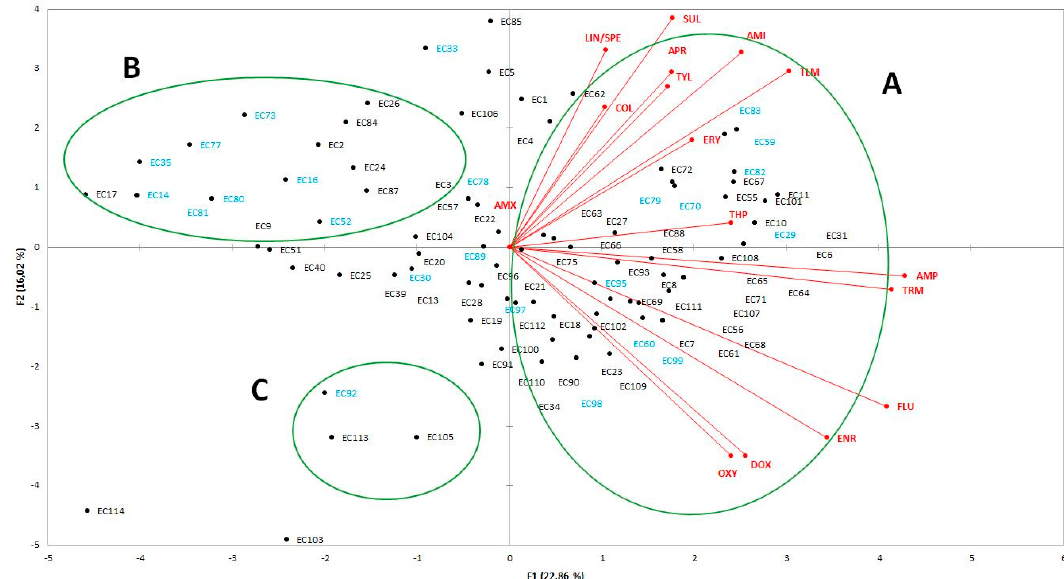
Figure 1. Biplot of principal component analysis (PCA) analysis showing the antibiotic resistance distribution among E. coli strains isolated from bovine (in blue) and poultry (in black).